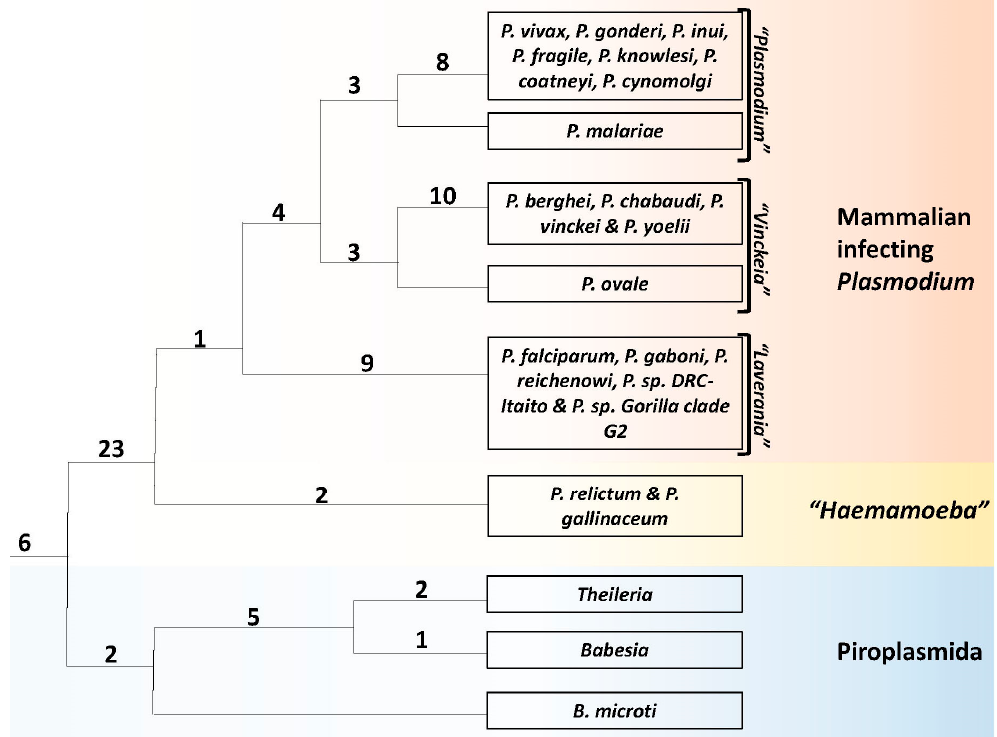
Figure 8. A conceptual diagram summarizing the evolutionary relationships among members of the class Hematozoa and the genus Plasmodium based on phylogenetic analysis and different identified molecular signatures (synapomorphies). The numbers of CSIs that are specific for different clades or species-groupings are noted on the respective nodes.